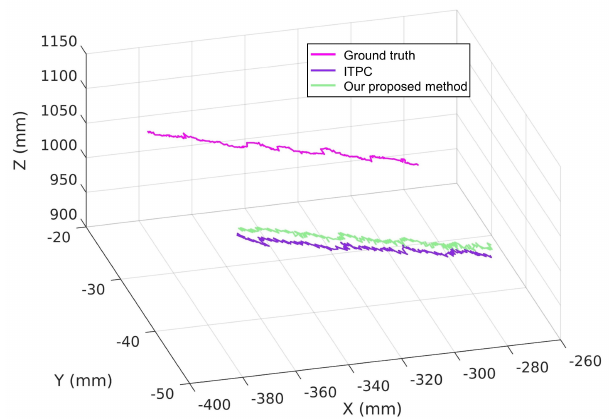
Figure 12. The trajectory of the ground truth and the estimated point P using our proposed method and ITPC